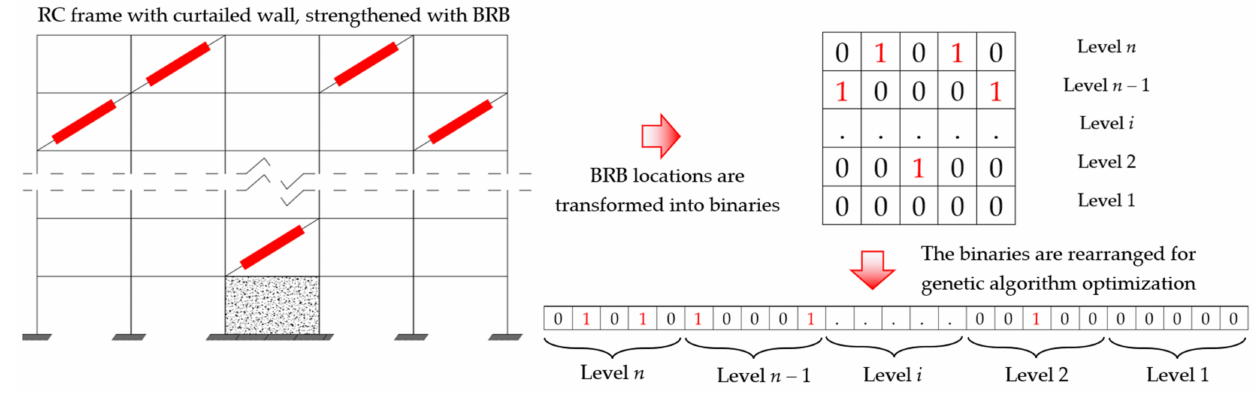
Figure 17. The diagram of BRBs location to binaries for Genetic Algorithm optimization